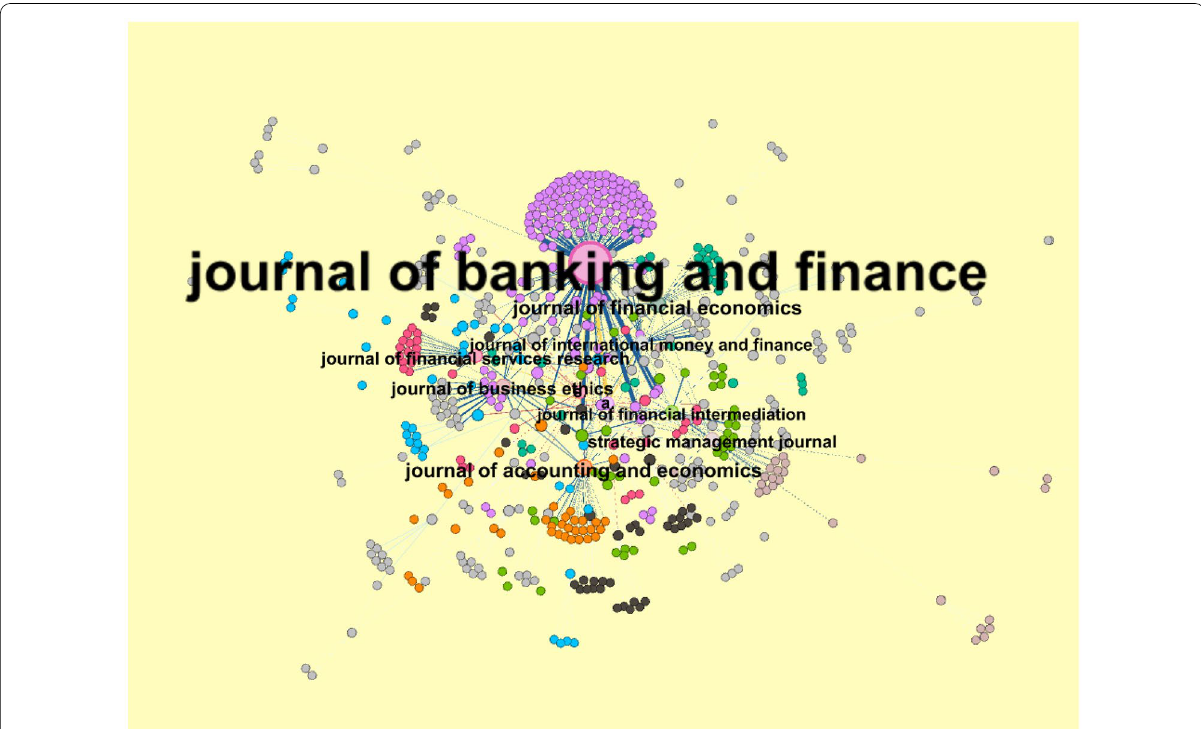
Fig. 4 Network analysis between authors and journals. Note A node size explains the more linked authors to a